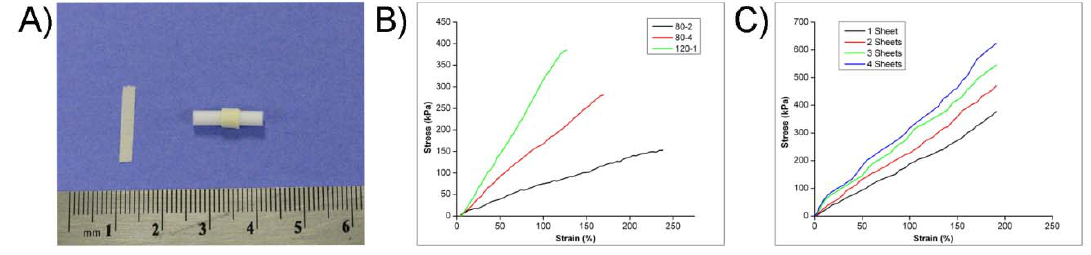
Figure 3. (a) Photograph of a single CUPE 1.2 scaffold sheet (left) and CUPE 1.2 scaffold sheet rolled onto a Teflon rod (right). Typical tensile stress-strain curves of (b) single CUPE 1.2 scaffold sheets post-polymerized under different reaction conditions and (c) multiple CUPE 1.2 scaffold sheets post-polymerized at 80 ° C for 4 days followed by 120 ° C for 1 day under vacuum.